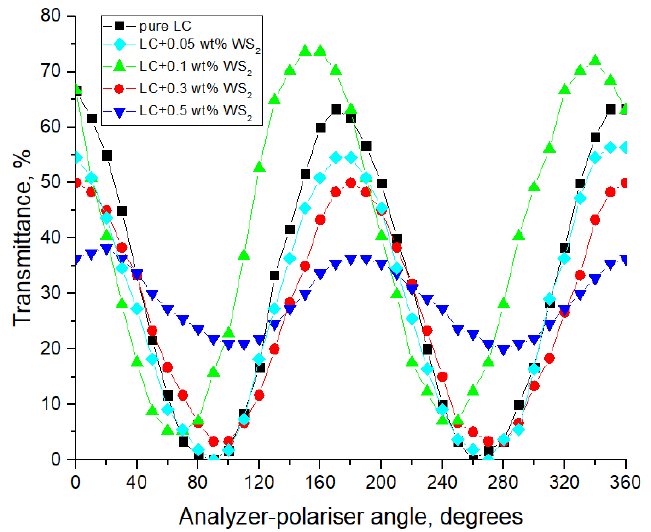
Figure 2. Experimental scheme for the measurement of the light plane polarization rotation: 1—Nd:YAG laser (532 nm); 2—polarizer; 3—tested LC cell; 4—analyzer; 5—photodiode with the oscilloscope.